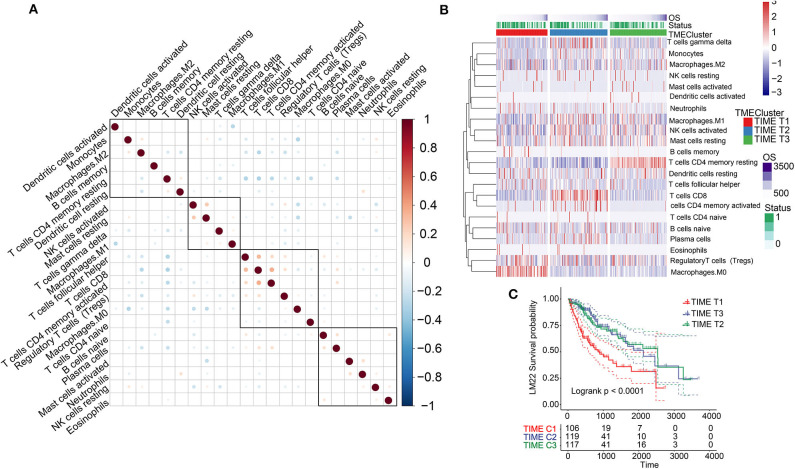
TIME-infiltrating cells and classification of TIME. (A) Correlations among 22 types of immune cells in TIME. Brown and blue nodes represent positive and negative correlations, respectively. The larger the node, the stronger the correlation. (B) Heat map illustrating results of unsupervised clustering based on TIME phenotypes. (C) Kaplan–Meier analysis for three TIME phenotypes.